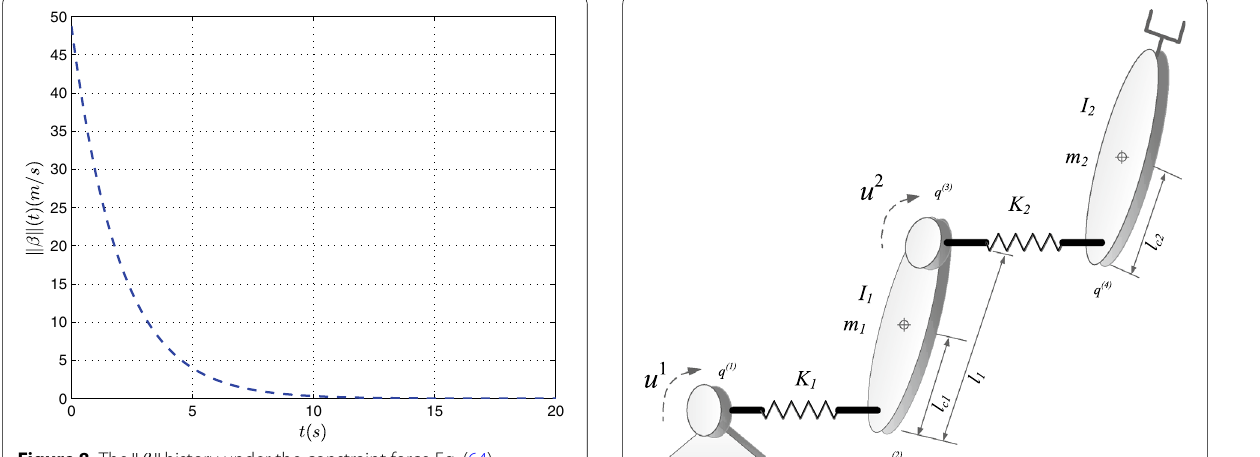
Figure 8 The (cid:31) β (cid:31) history under the constraint force Eq. (64)